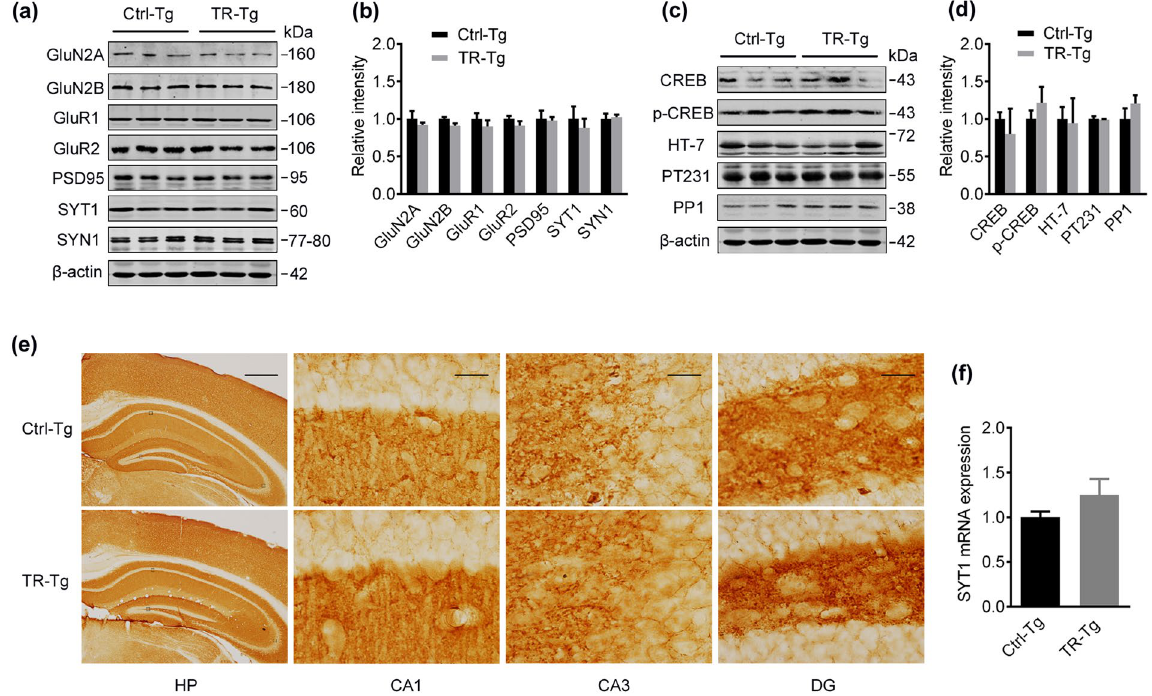
Figure 5. Paternal spatial training for 1 week does not improve synapse- or memory- associated proteins in 3XTg F1 offspring. ( a,b ) Synapse-associated proteins in 7-m 3XTg F1 offspring measured by Western blotting. ( c,d ) Memory-associated proteins (CREB, p-CREB), human tau (HT-7), phosphorylated tau (PT231) and PP1 in hippocampus of 7-m 3XTg offspring measured by Western blotting. The blot images in ( a–d ) were cropped to display and quantitifed by the Odyssey Infrared Imaging System (Licor biosciences, Lincoln, NE, USA). Bar graphs show mean ± SEM. (two-tail t-test, n.s, n = 3 per group). ( e ) Immunohistochemical staining of SYT1 in cortex and hippocampus of 7-m 3XTg offspring brain slices. The HP panel: scale bar = 50 μ m; the enlarged CA1, CA3 and DG: scale bar = 2 μ m. ( f ) SYT1 mRNA level in hippocampus of 7-m 3XTg offspring measured by quantitative RT-PCR. Bar graphs show mean ± SEM (two-tail t-test, n.s, n = 3 per